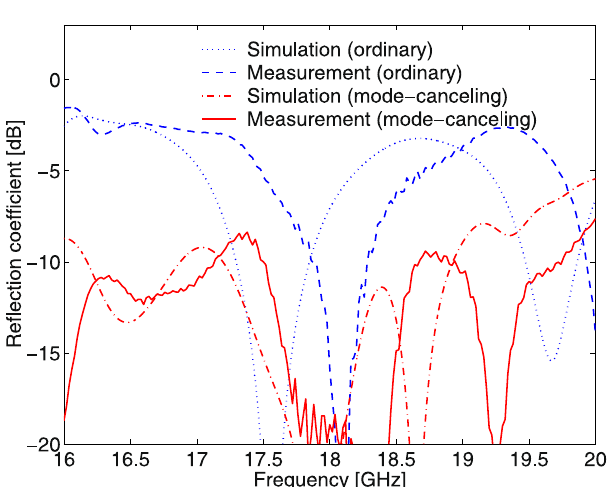
= = ) and mode-canceling main sub